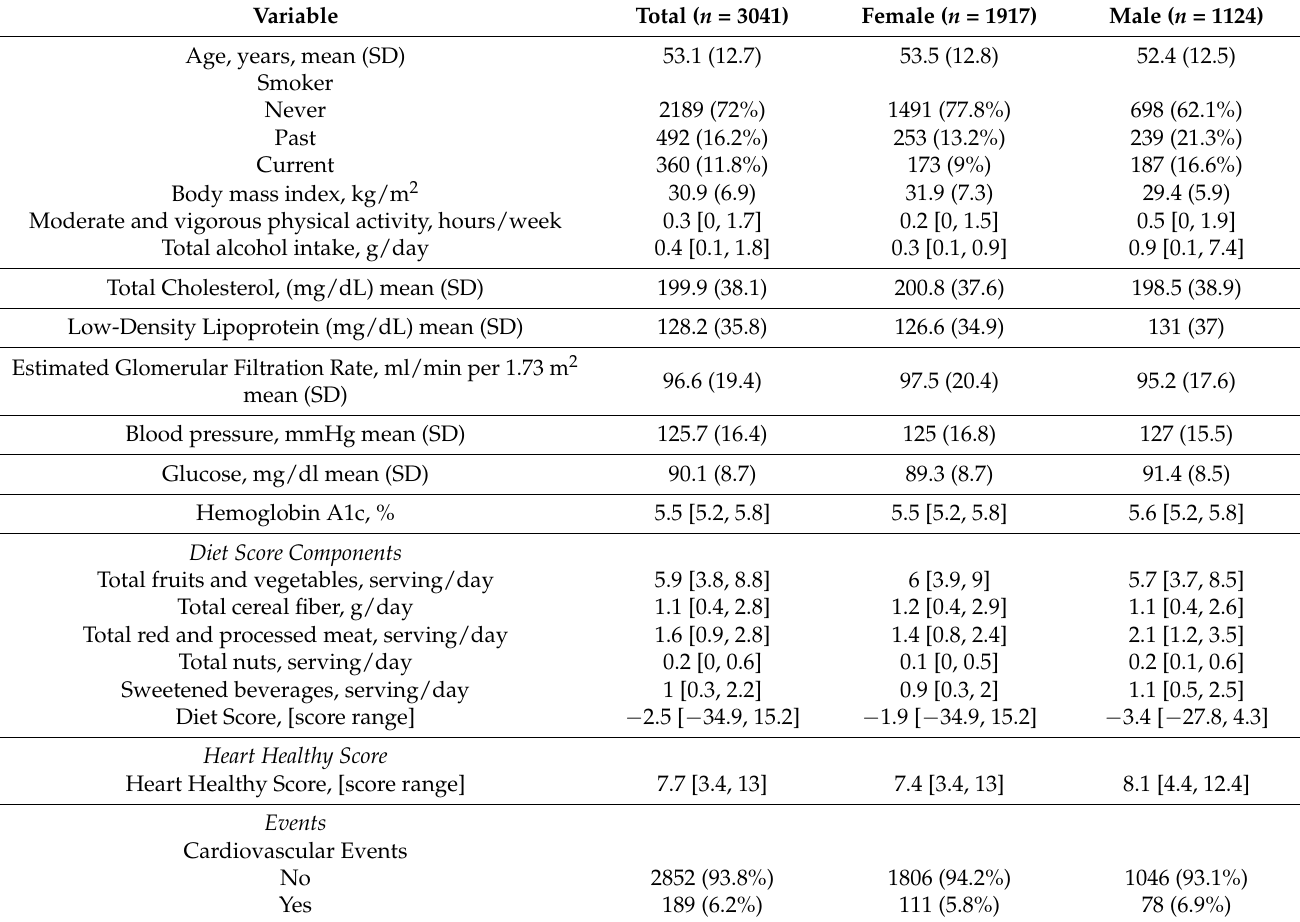
Table 1. Baseline demographics of participants in the Jackson Heart Study, by sex and overall